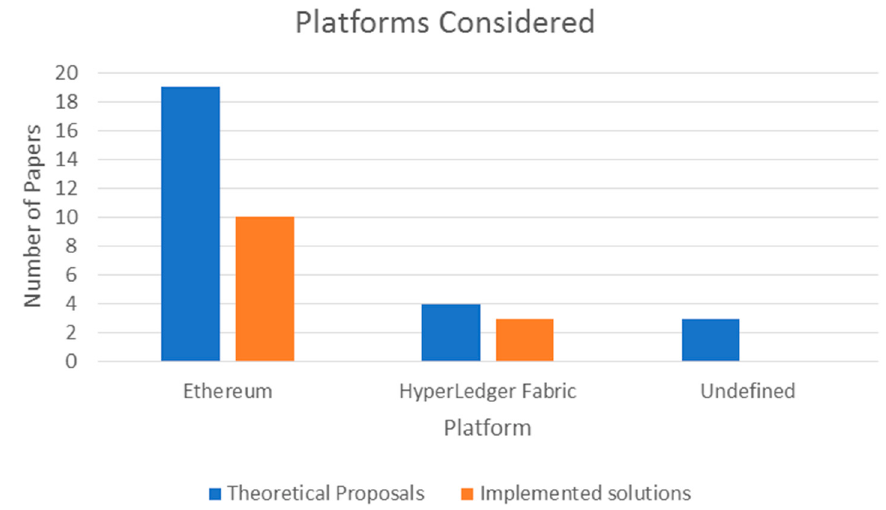
Figure 6. Blockchain platforms considered for solutions.